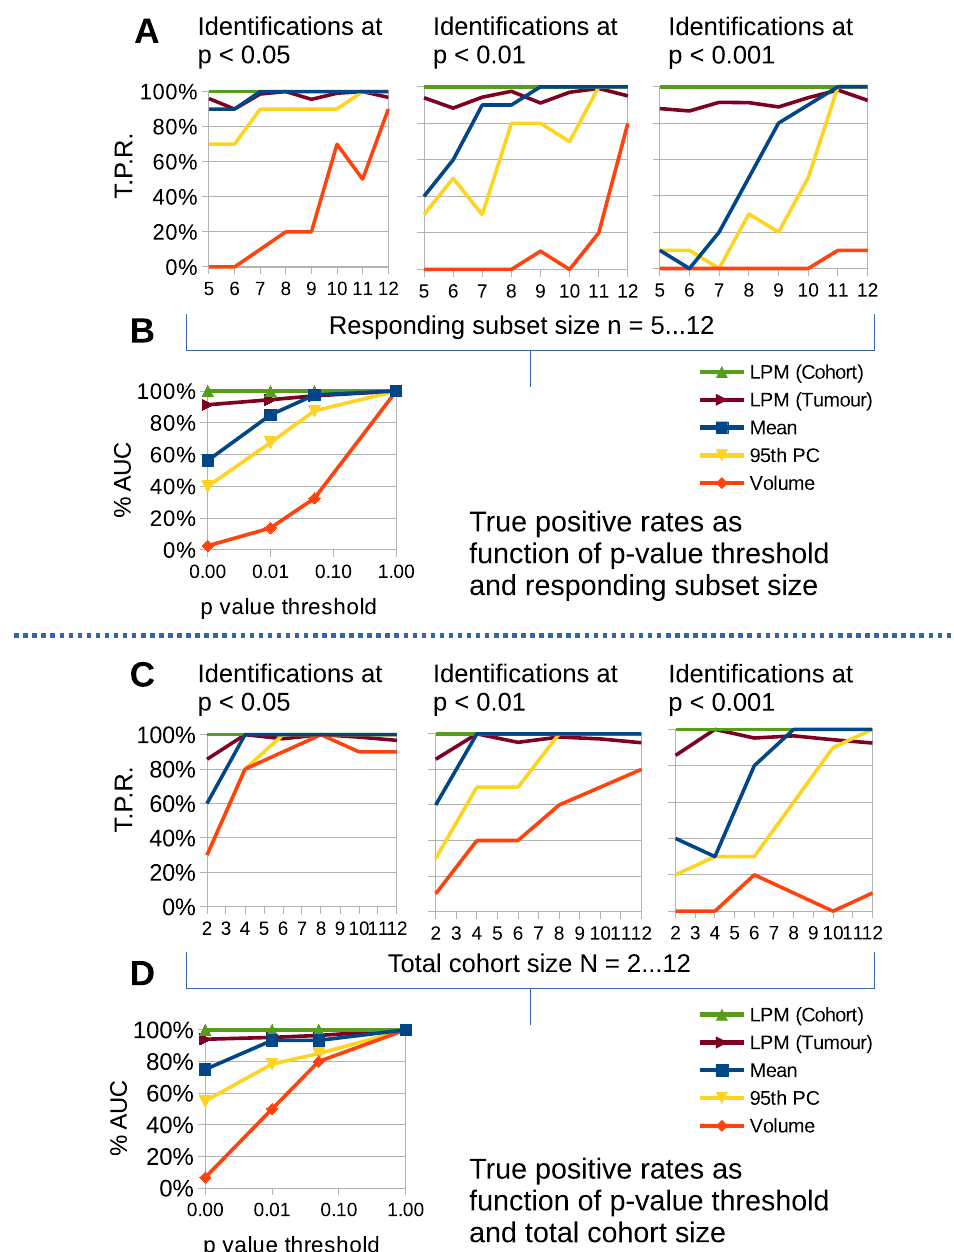
Figure 8. Simple parameter t -tests and LPM detections compared on simulated data as a function of responding subset size ( n ∈ N ), total cohort size ( N ) and statistical significance threshold for detection. Plots show true positive detection rates for null-hypothesis rejection. ( A ) TPR as function of responding subset size, n , down to less than half responding from a total of N = 12. ( B ) Area under curve summary of TPRs as function of significance threshold found in ( A ). ( C ) TPR as function of total cohort size N . ( D ) Area under curve summary for ( C